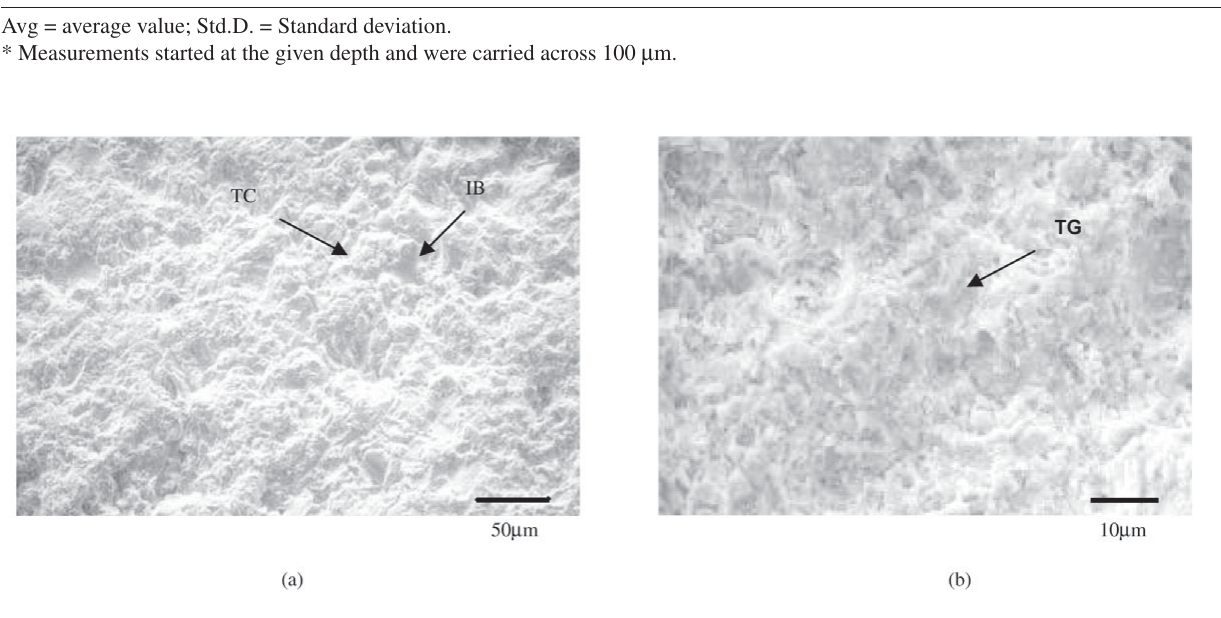
Figure 2. Tribography of CSZ sample, in eroded condition: a) 50 µ m; b) 10 µ m, marks.